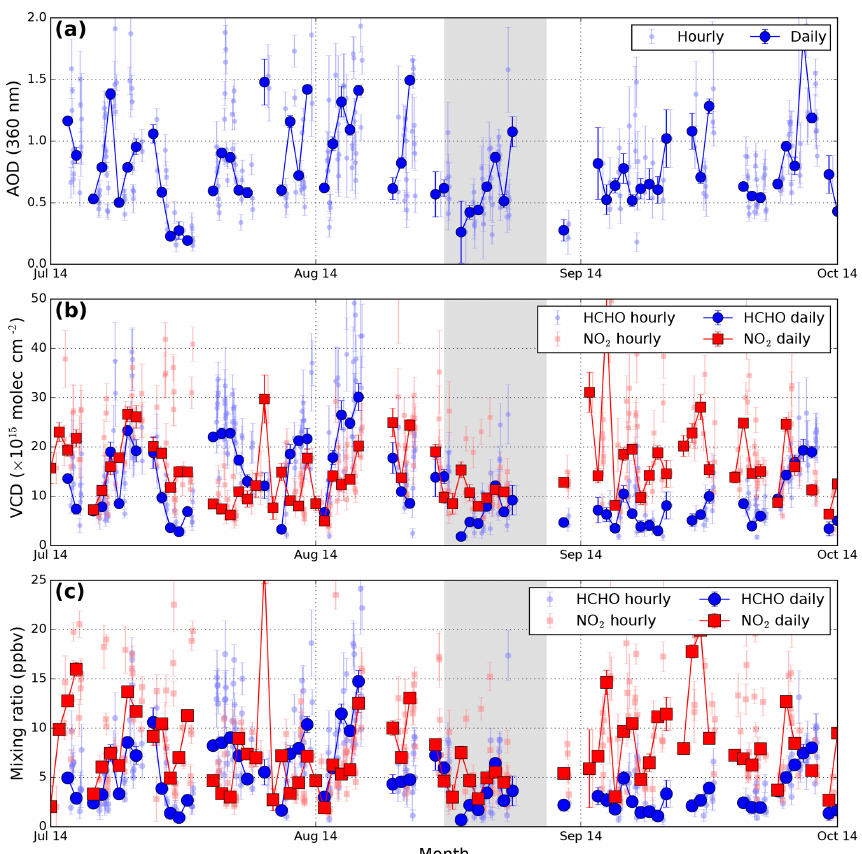
Figure 11. Time series of (a) aerosol optical depths, (b) HCHO and NO 2 VCDs and (c) HCHO and NO 2 surface mixing ratios measured by the MAX-DOAS around the Youth Olympic Games. Hourly and daily averaged values are shown. The gray shadowed area indicates the Youth Olympic Games period (16 to 28 August